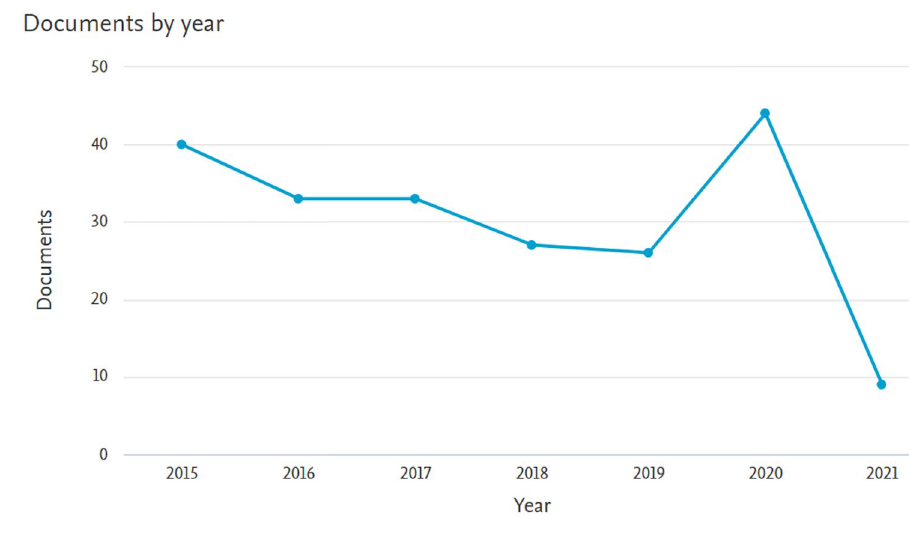
Fig. 5 Documents by Year and Source (Source: www. scopus. com)